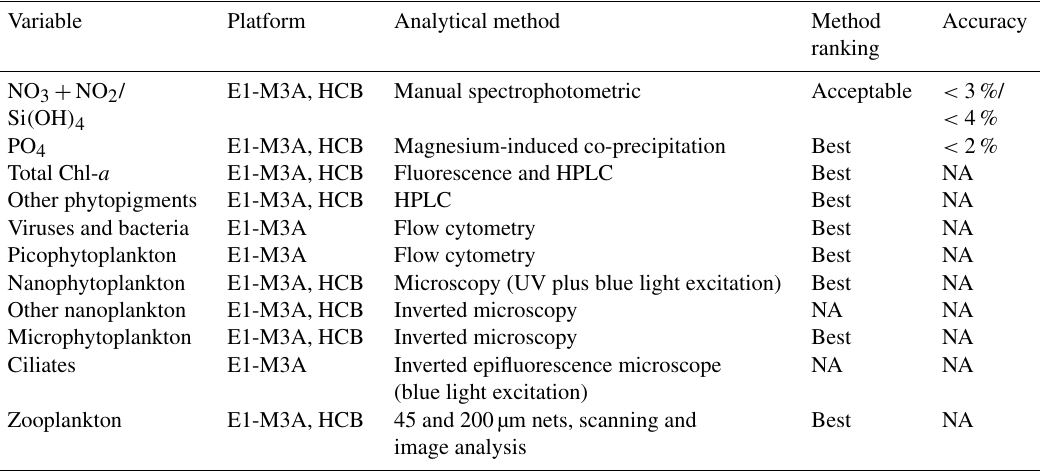
Table 2. Variables measured from discrete bottle and net samples at high frequency (monthly). The method ranking is from Lorenzoni and Benway (2013).